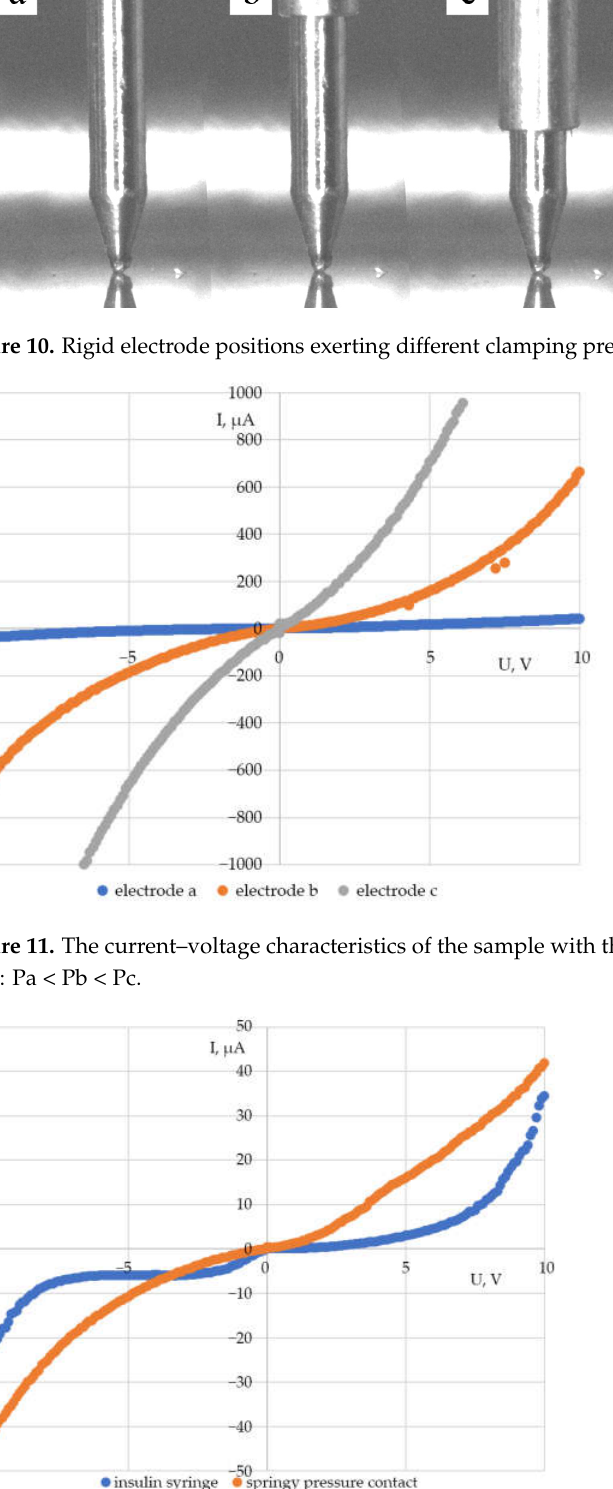
Figure 12. Comparison of the current–voltage characteristics of the sample obtained using a liquid and a rigid electrode.